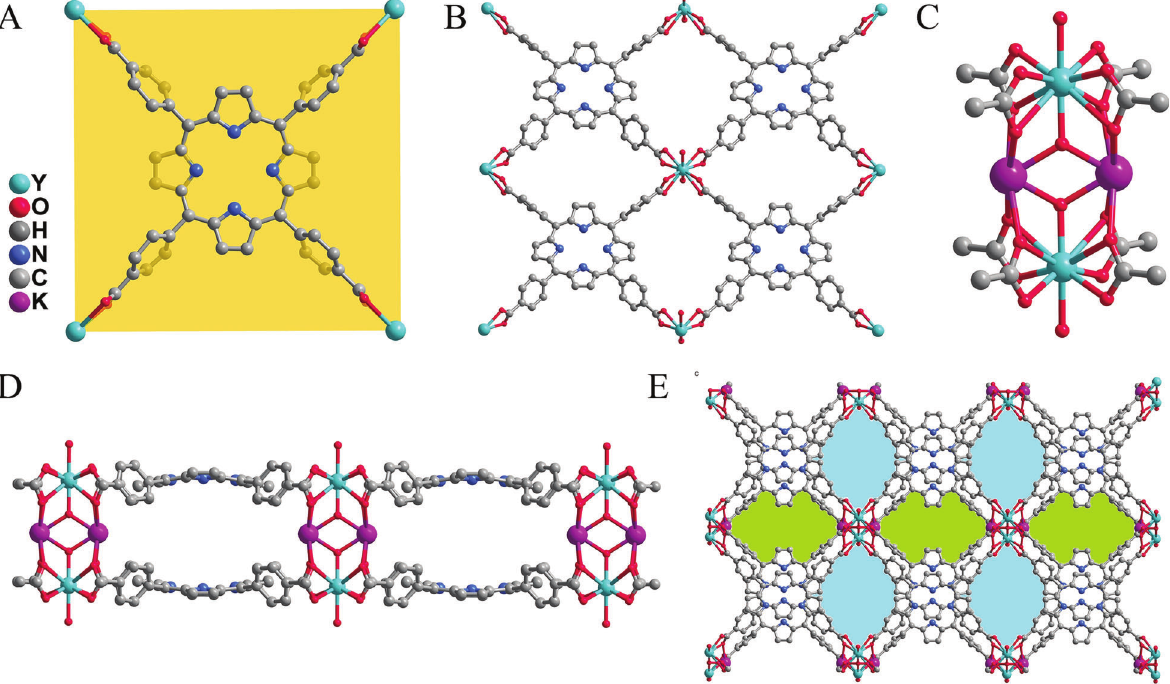
Figure 2. A , Coordination environment of TCPP ligand in complex 1, the linker exhibit a saddled out of plane deformation. The yellow plane represents the mean porphyrin plane created through pyrrolic N atoms. B , The in fi nite 2D sheet formed by the connection of Y ions and TCPP linker. C , Coordination environments of Yand K ions. D , Side view of the double-sheeted layer formed by the connection of K ions and porphyrin sheet, illustrating the bilayered arrangement of the porphyrins. E , Channels propagate along the a -axis, green color: 5.4 (cid:3) 13.4 Å, blue color: 13.3 (cid:3) 8.7 Å, atom to atom distance.